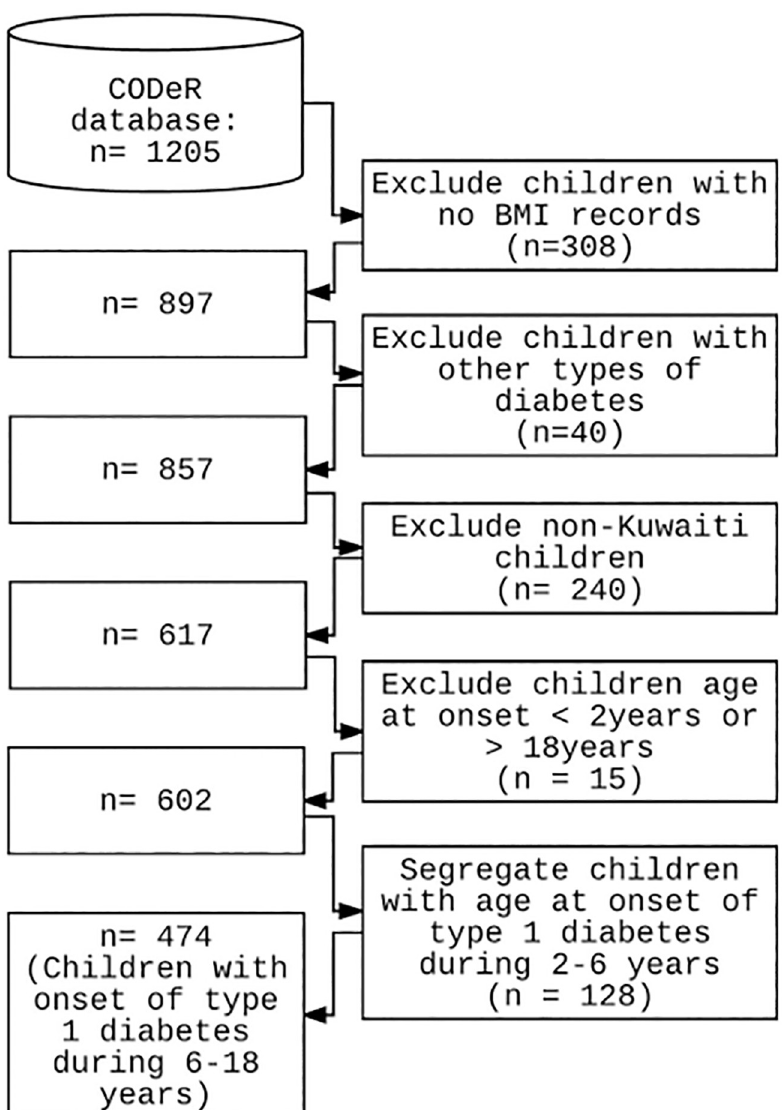
Fig 1. Flowchart depicting the filtering steps used to derive the data sets on children and adolescents with age at onset of T1D during 2 to < 6 years, and during 6 to18 years.